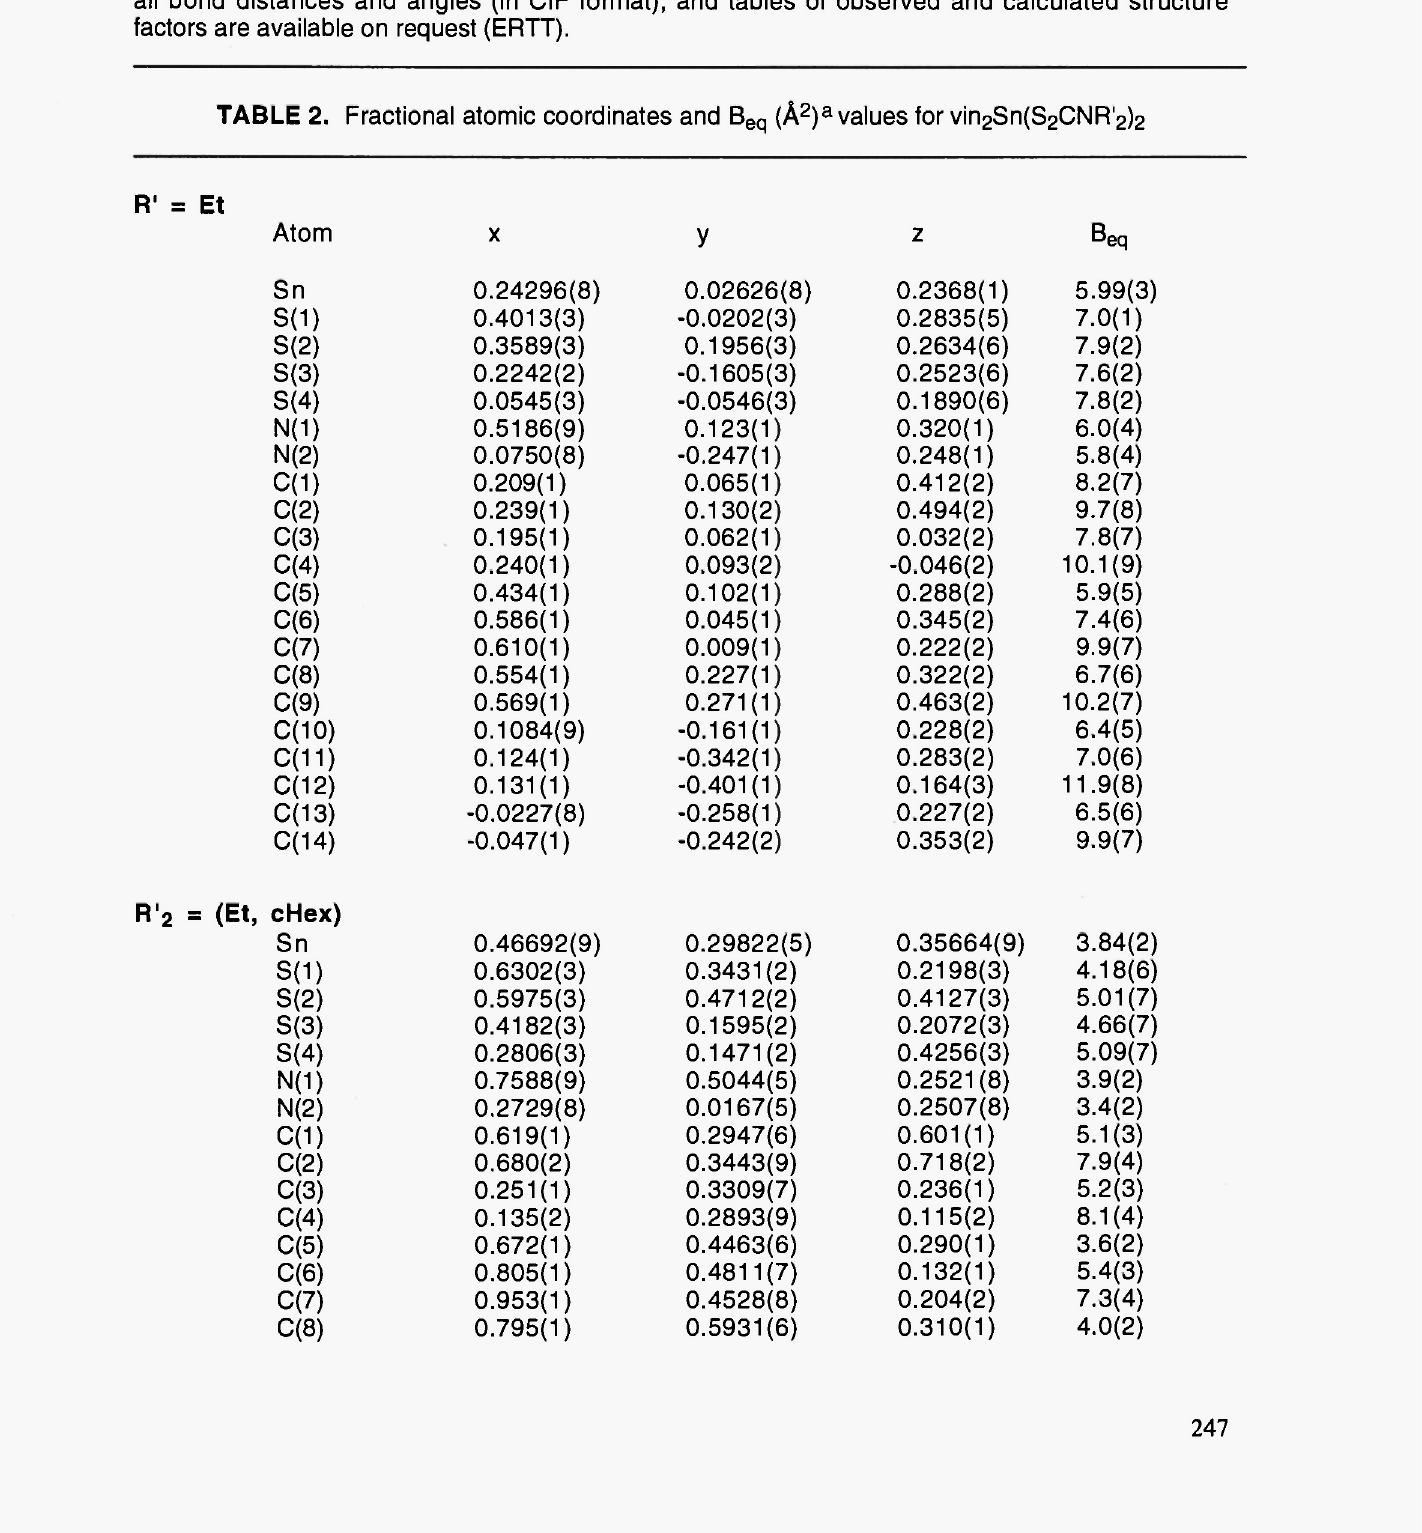
TABLE 2. Fractional atomic coordinates and B eq (Ä 2 ) a values for vin 2 Sn(S2CNR' 2